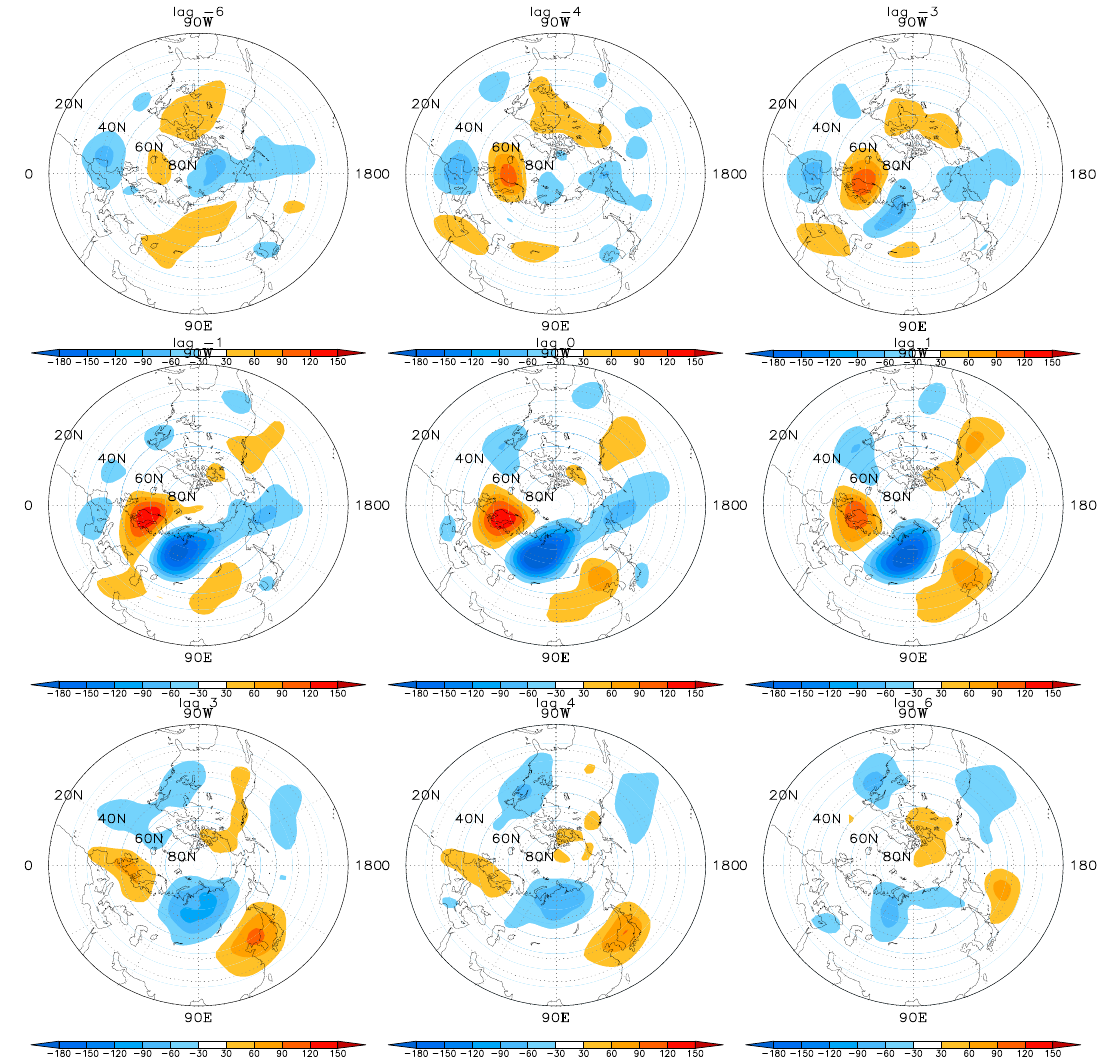
Figure 12. The 500 hPa geopotential height anomaly field in the negative EU phase at a lag of − 6 days,